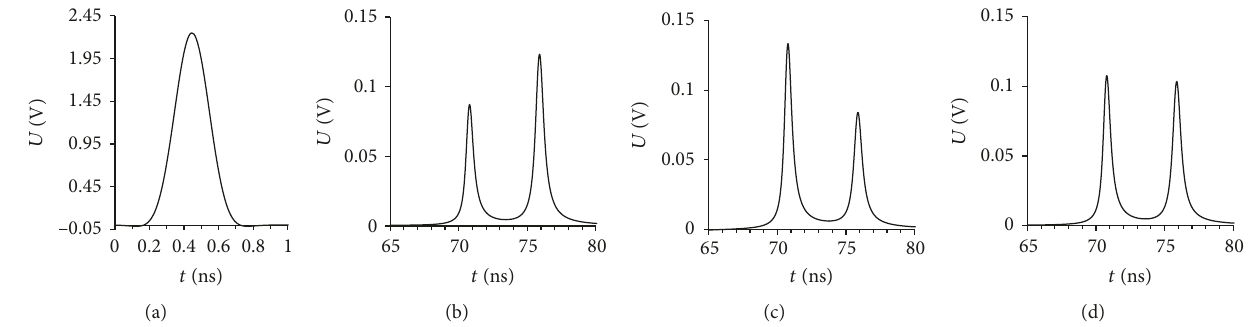
Figure 8: Simulated waveforms of input signal (a) and signal at the far end of the probing line ( 𝑉4 ) with open circuit (b), short circuit (c), and 100 Ω (d) at both ends of the probed conductor.